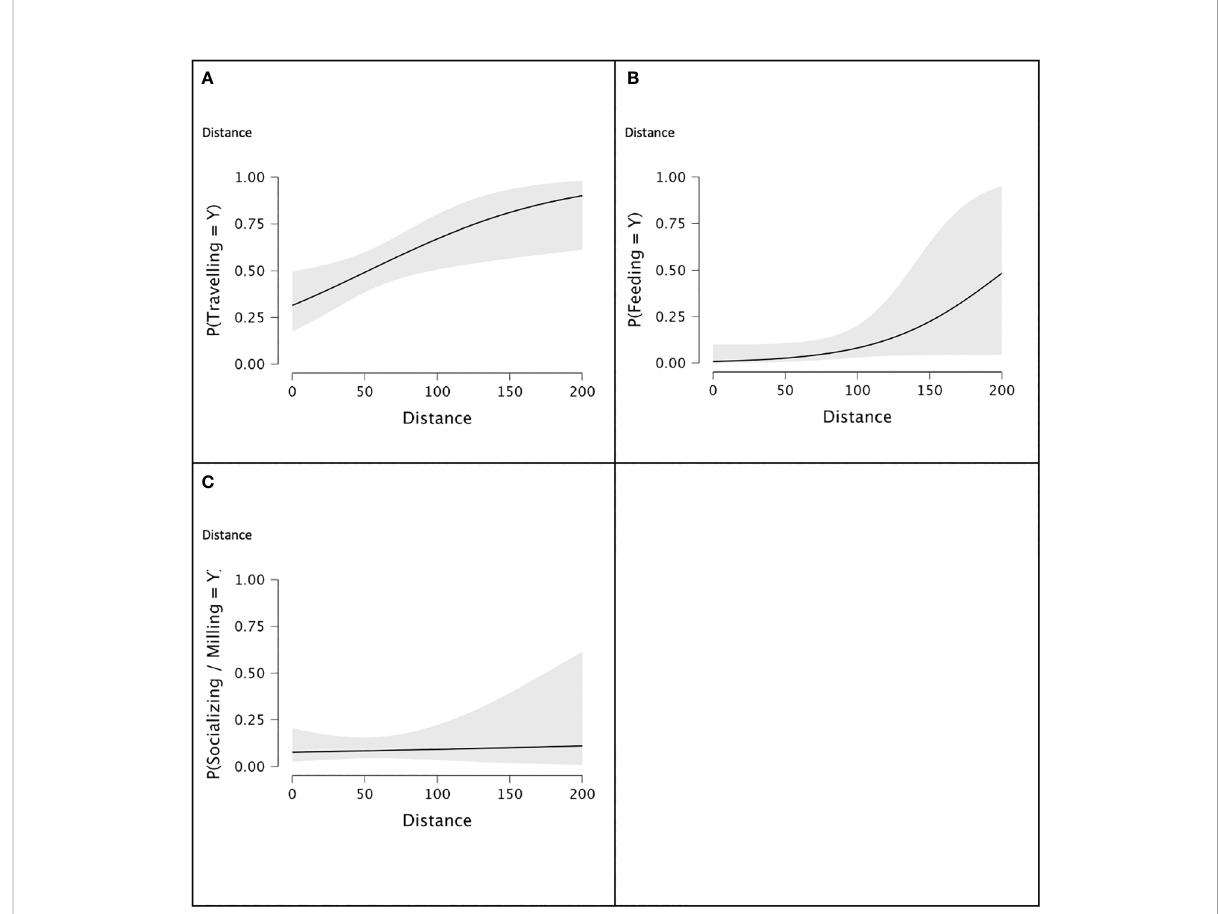
FIGURE 3 Probability of beluga behaviours with Distance with Year and Group class as logistic regression factors: (A) - Travelling seen from Sea North II vessel or zodiacs in 2019, 2020 and 2021; (B) - Feeding seen from Sea North II vessel or zodiacs in 2019, 2020 and 2021; (C) – Socializing/ Milling seen from Sea North II vessel or zodiacs in 2019, 2020 and 2021, where P(Behaviour = Y) means the probability of a behaviour occurring, i.e., Y means “ Yes ” ). Shaded areas around the regression line represent the 95% con fi dence.